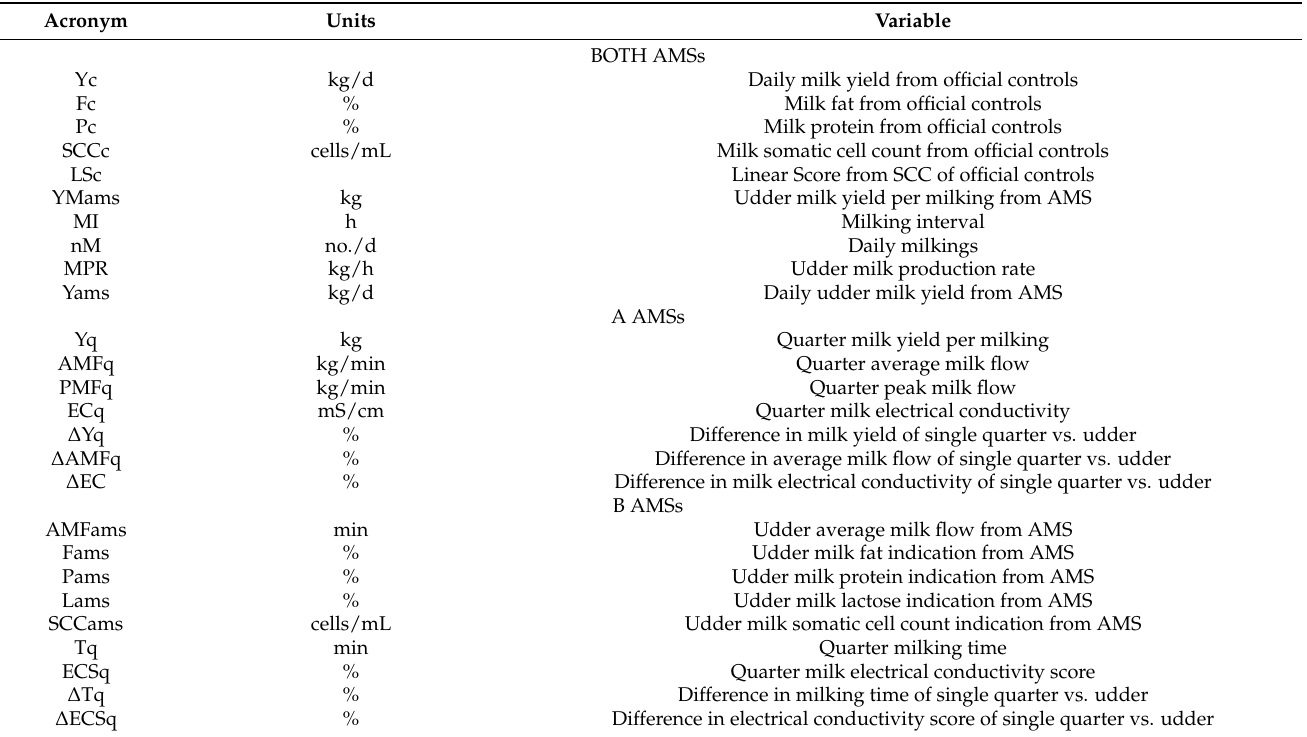
Table 2. Variables analysed for the two types of AMS, their acronyms and